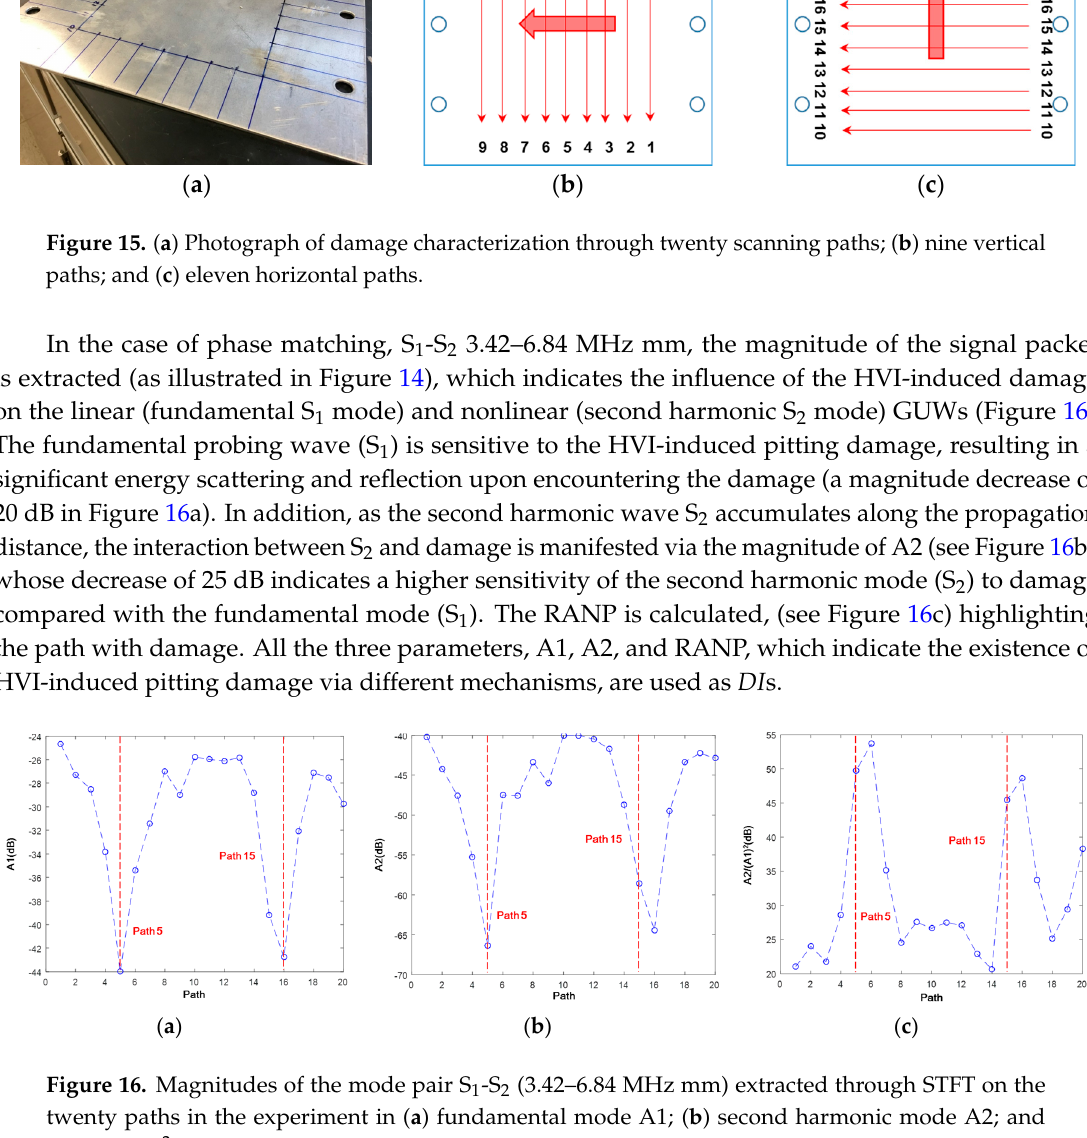
Figure 14. Schematic of linear/nonlinear guided wave-based damage characterization.